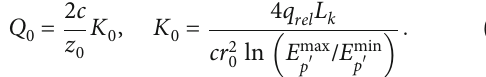
ffiffiffiffiffi p α ′ , and α = 0 : 98/